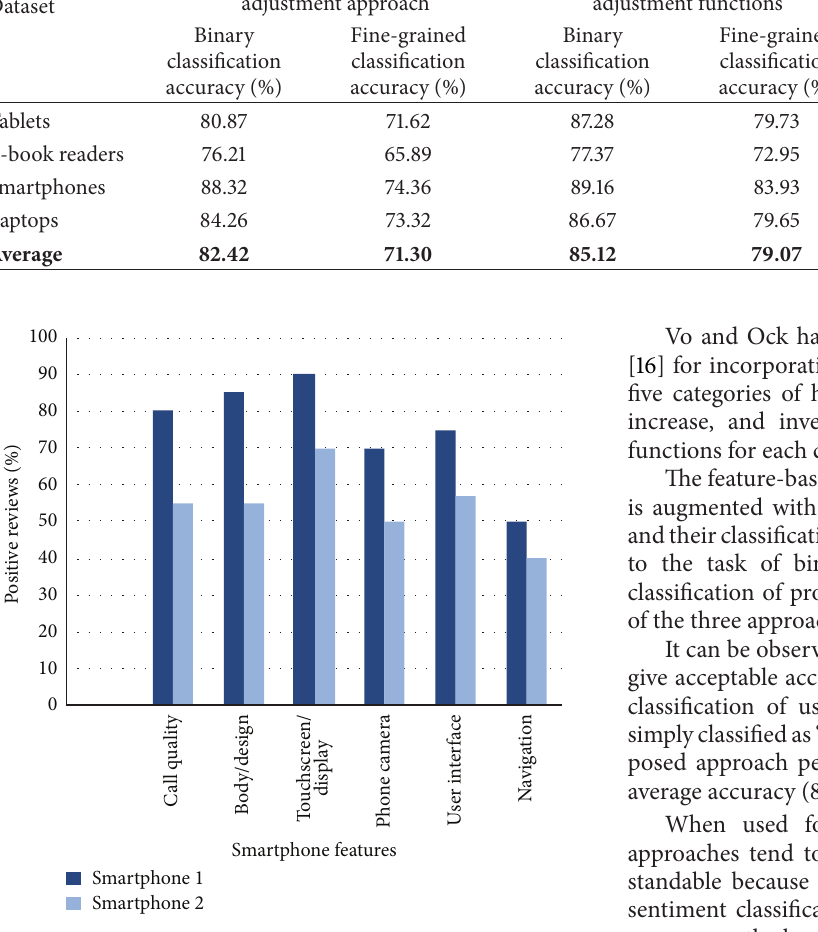
Figure 4: Comparative featurewise summary of two